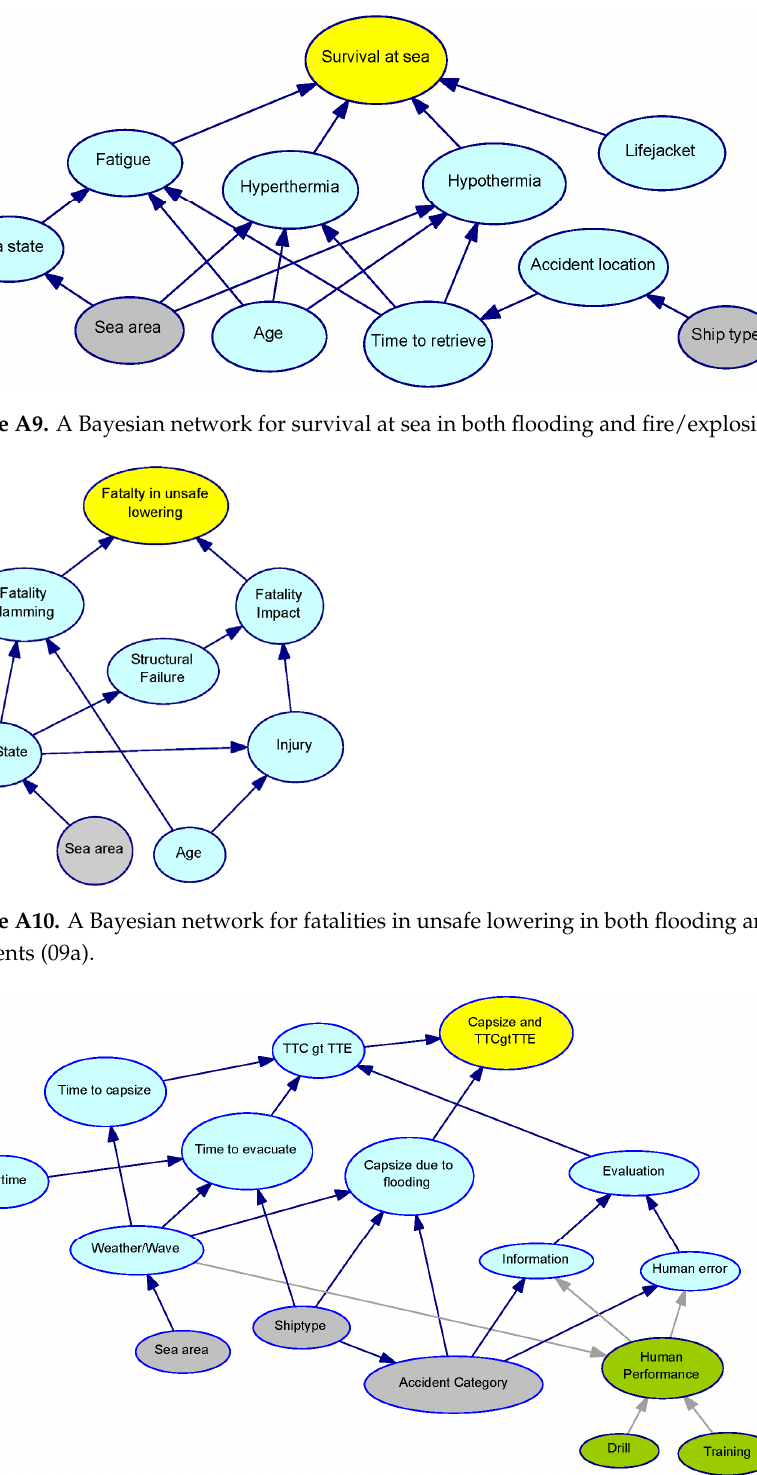
Figure A8. A Bayesian network for survival in the lifeboat in flooding and fire/explosion accidents